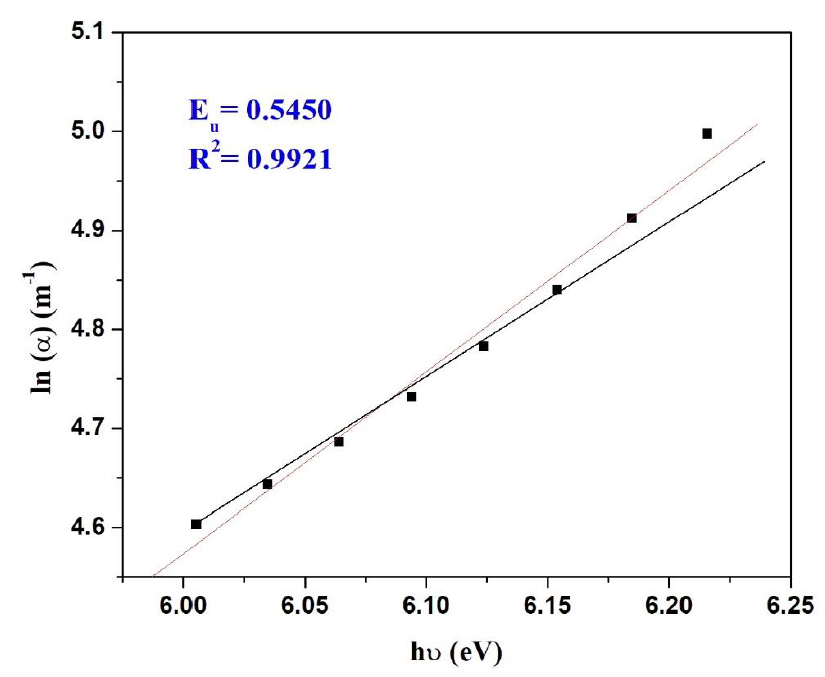
Figure 9. Graph of ln ( α ) and h υ —Urbach energy.